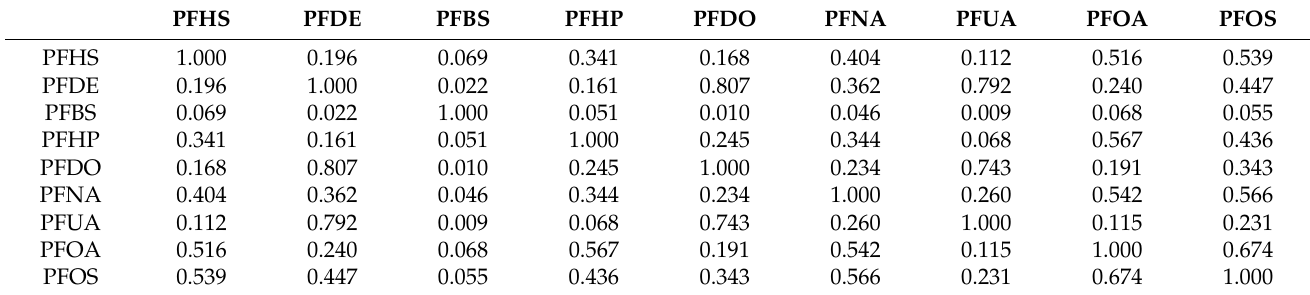
Table 6. Pearson correlation was used to describe the relationships between selected PFAS.